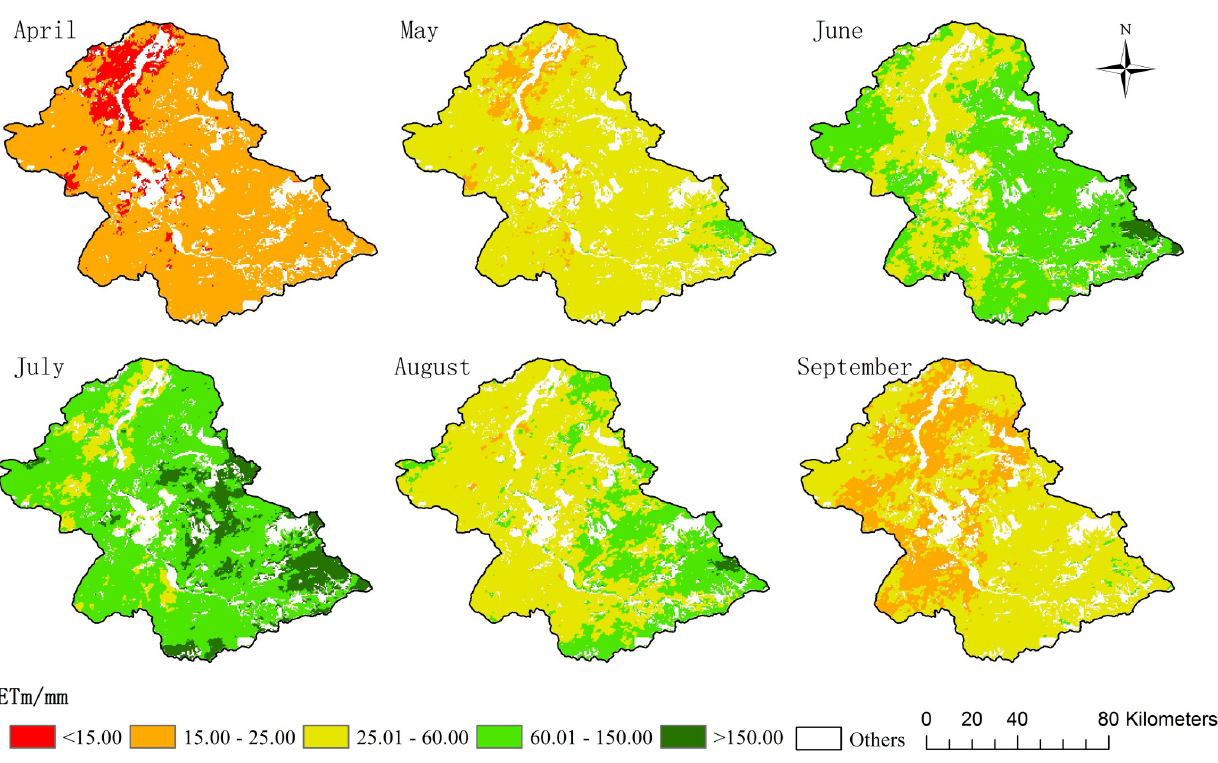
Fig 6. Monthly evapotranspiration in the Xilin River Basin from April to September 2014.